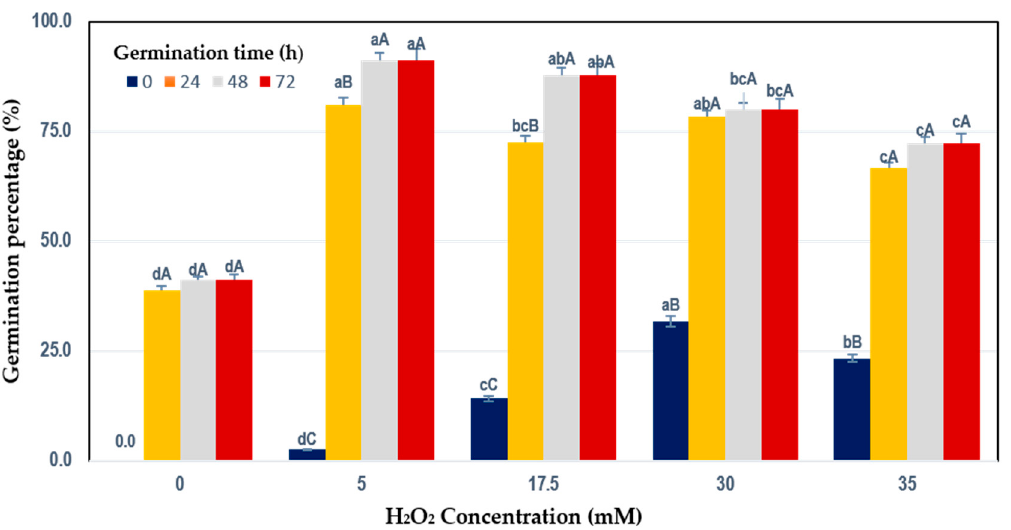
Table 2. Results of the regression analysis of predicted quadratic polynomial models for each of the response variables of chickpea sprouts.